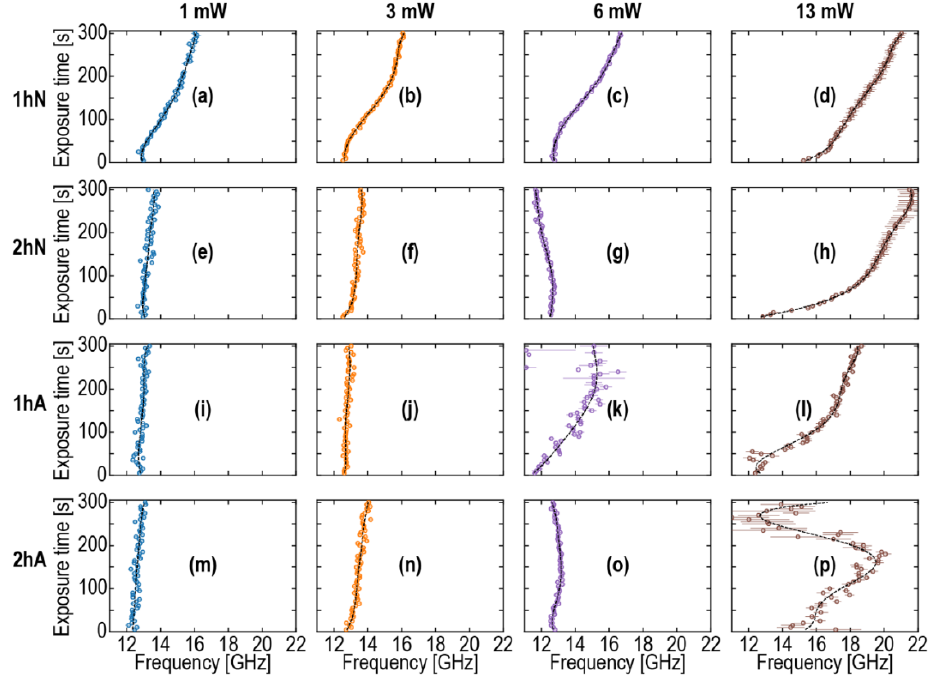
Figure 5. Changes in Brillouin frequency with the duration of the TDBS measurements at different powers of probe laser pulses (marked on the top of the figure) with a 26 mW pump power in the 1 hN (first row, ( a – d )), 2 hN (second row, ( e – h )), 1 hA (third row, ( i – l )), and 2 hA (last row, ( m – p )) samples.